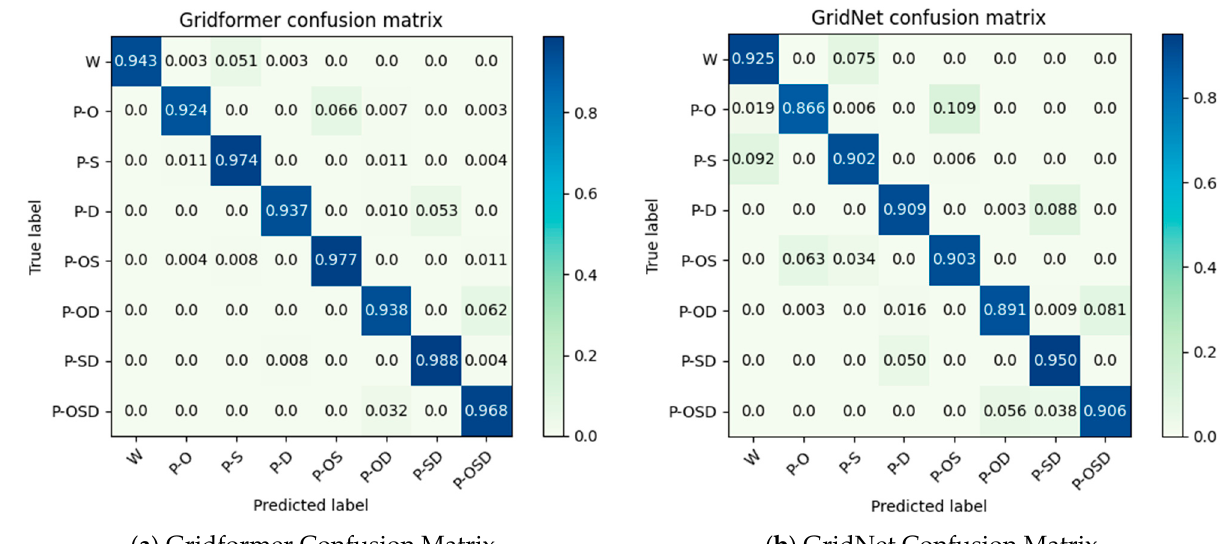
Figure 12. Gridformer Confusion Matrix vs. GridNet Confusion Matrix.